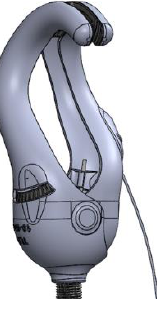
Figure 2. Conceptual design: gripper and hook with force regulation.